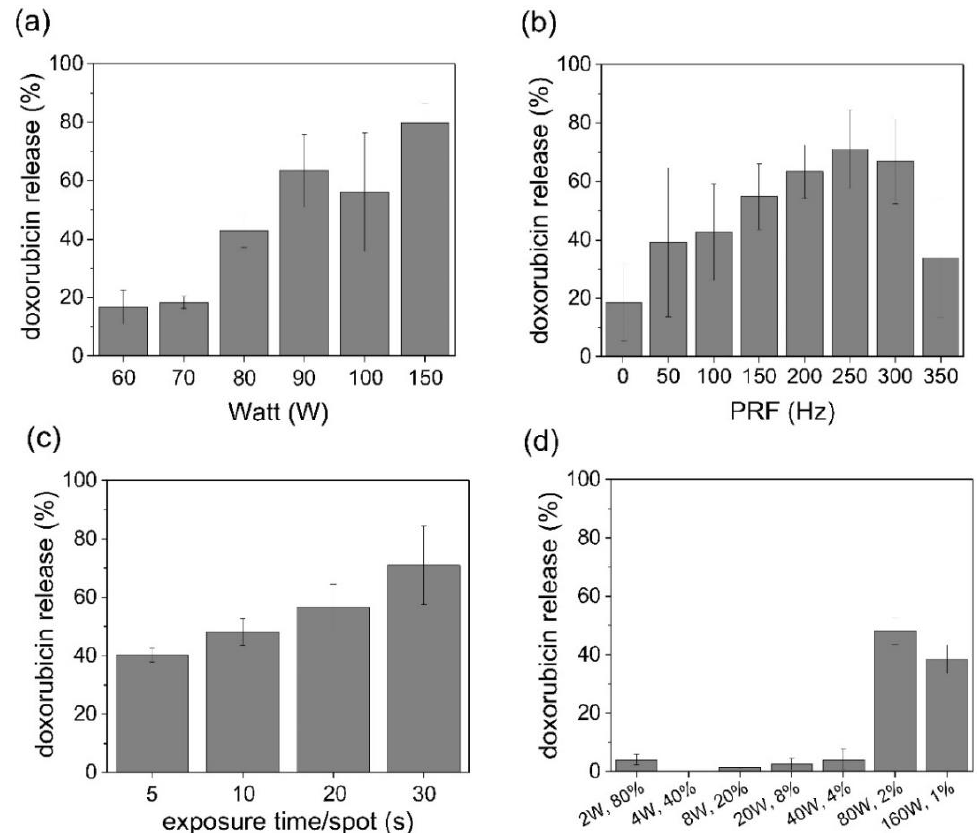
Figure 3. In vitro doxorubicin (DOX) release patterns in IMP301 according to different FUS parameters. ( a ) The amount of DOX released depended on intensity (at 250 Hz PRF, 10 s/spot, and 2% duty cycle). ( b ) The amount of DOX released depended on PRF (at 2.8 kW/cm 2 , 10 s/spot, and 2% duty cycle). ( c ) The amount of DOX released depended on irradiation time (at 2.8 kW/cm 2 , 250 Hz PRF, and 2% duty cycle). ( d ) The amount of DOX released depended on intensity (W) and duty cycle (%) (at 2.8 kW/cm 2 , 250 Hz PRF, and 10 s/spot).